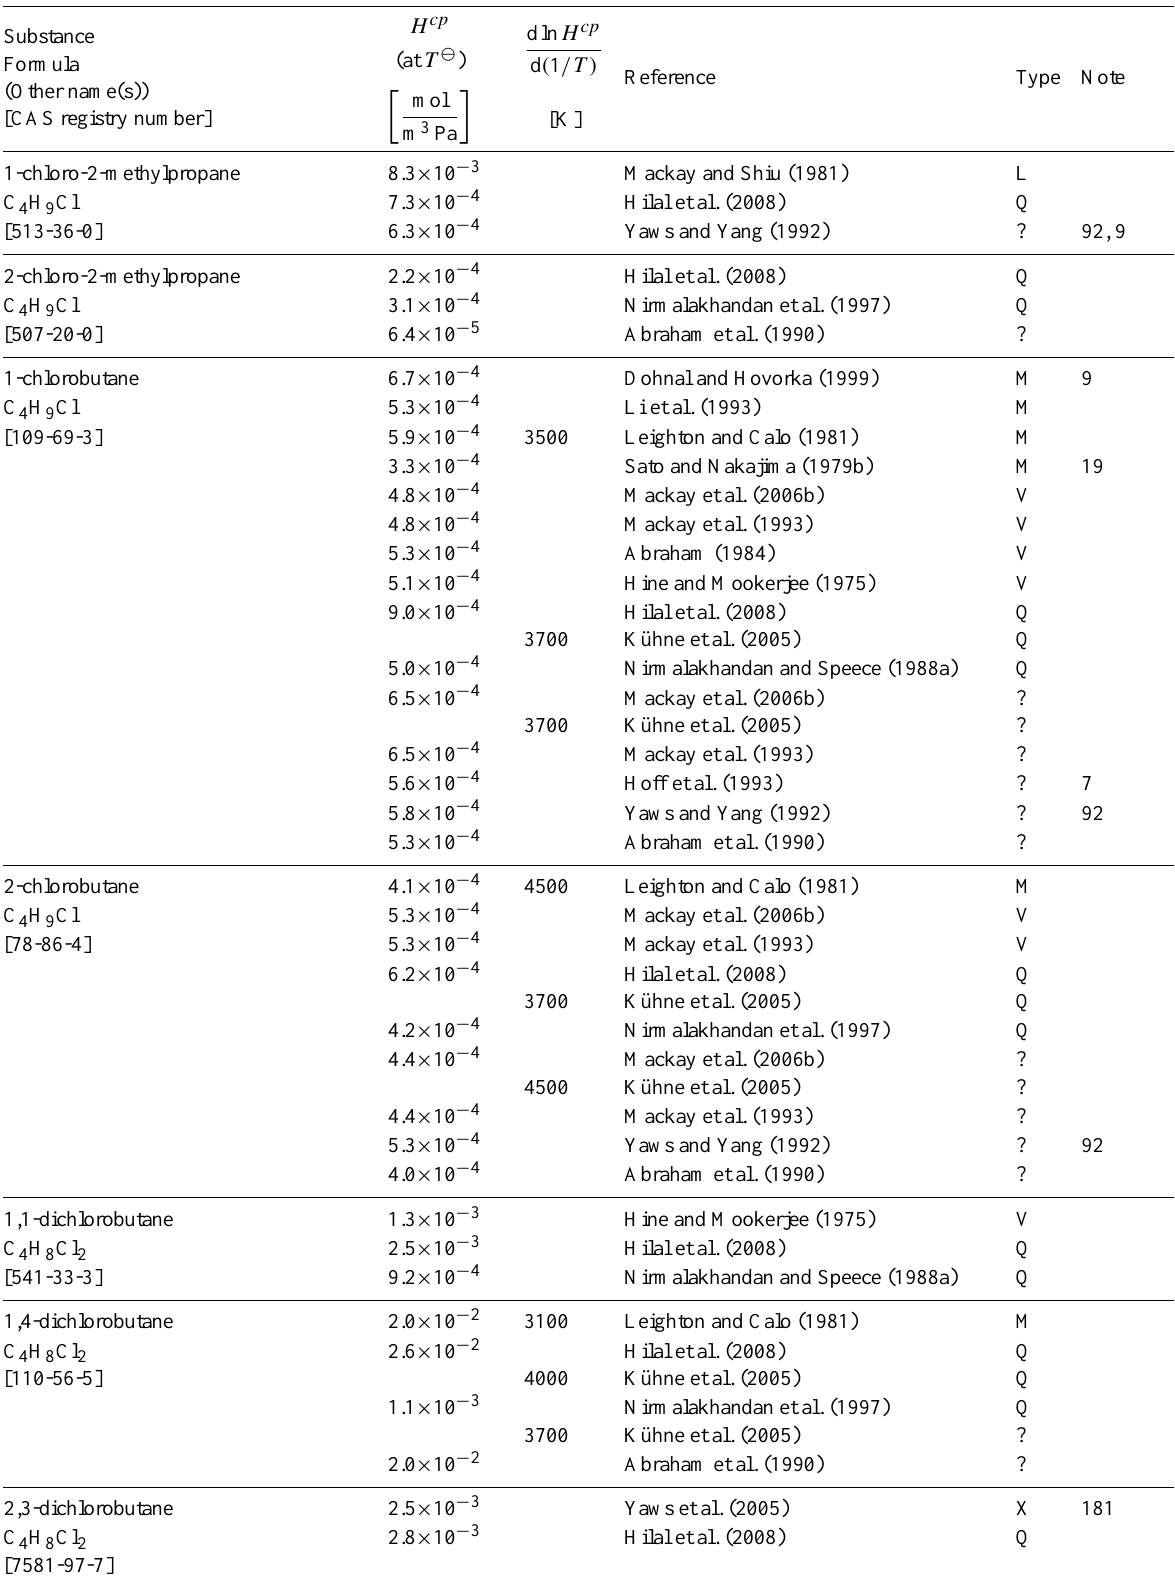
Table 6: Henry’s law constants for water as solvent